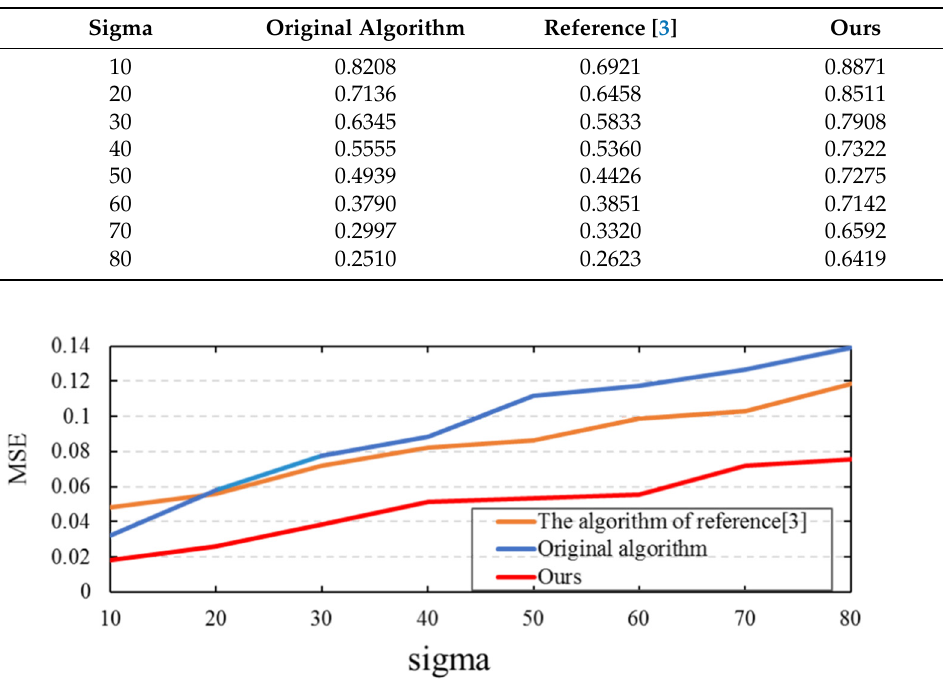
Figure 10. MSE line chart of the three algorithms for the MIT image.